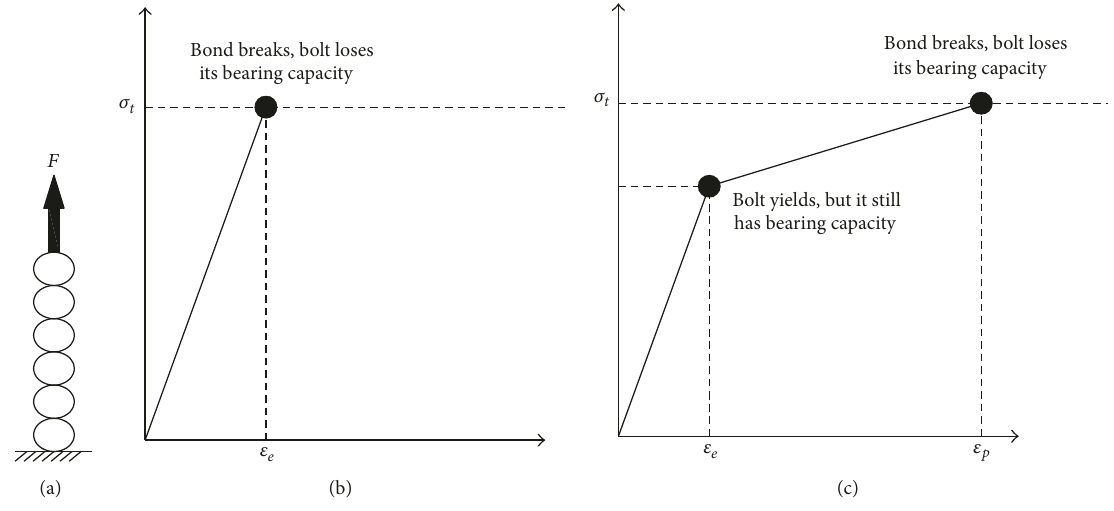
Figure 5: Illustration of the pull-out test for rock bolts and the constitutive rock bolt models.